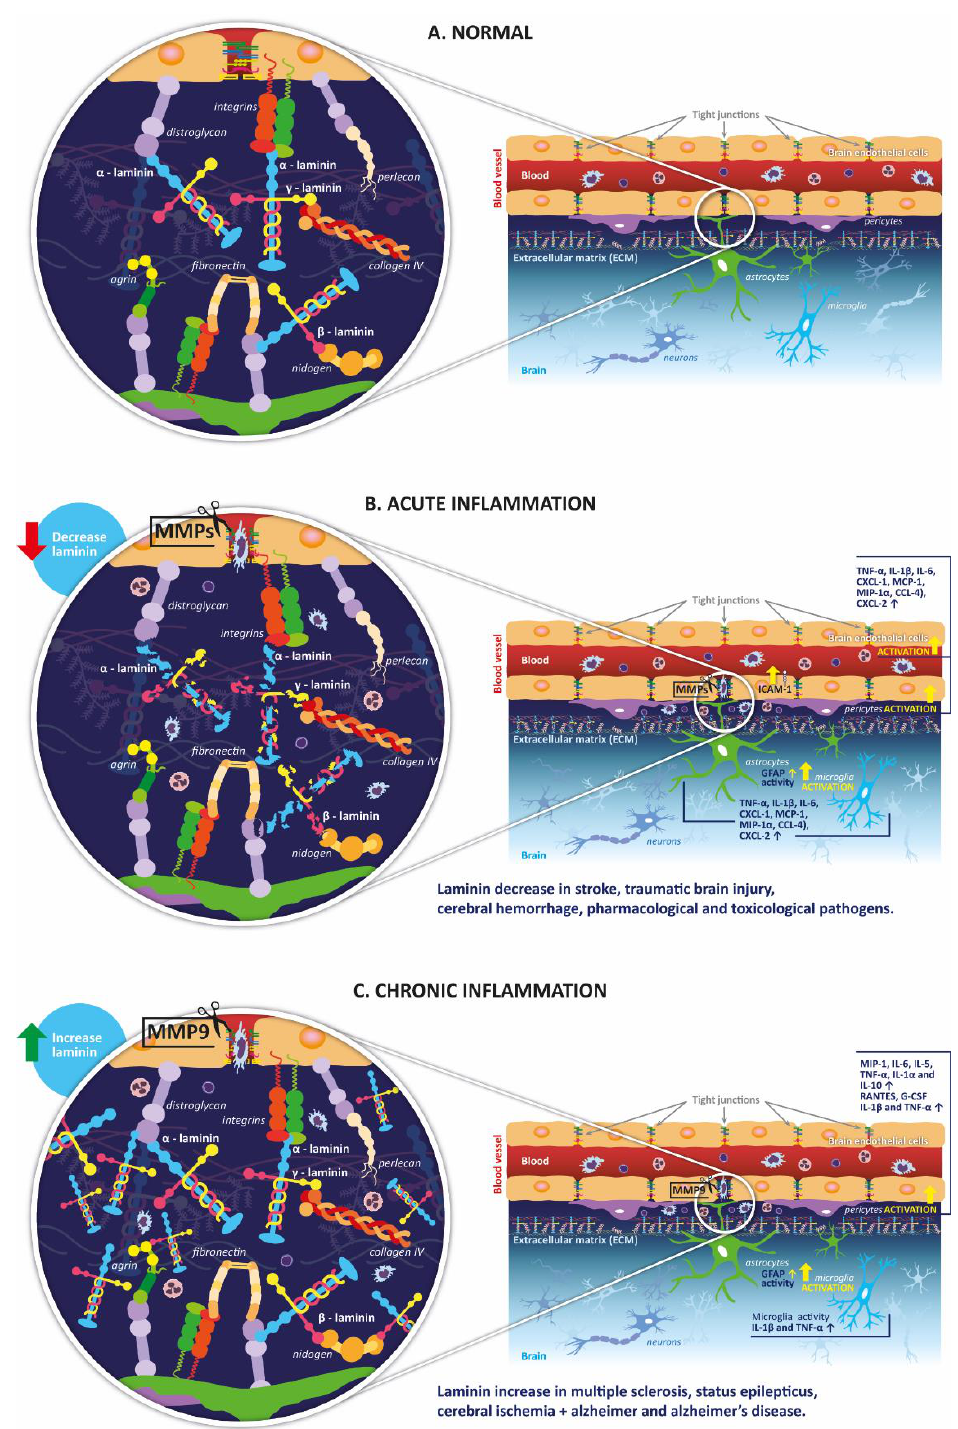
Figure 3. Schematic representation of the main findings in the systematic review regarding laminin. Panel ( A ) represents physiological interactions of laminin in the ECM, and with astrocytes, pericytes, and endothelial cells. Panel ( B ) represents changes in laminin during acute neuroinflammation where a decrease in laminin is reported. Panel ( C ) represents changes in laminin during chronic neuroinflammation where an increase in laminin is reported. Abbreviations: glial fibrillary acidic protein (GFAP); granulocyte colony-stimulating factor (G-CSF); interleukin (IL); macrophage inflammatory proteins (MIP); matrix metalloproteinases (MMP); monocyte chemoattractant protein 1 (MCP-1); tumor necrosis factor (TNF).